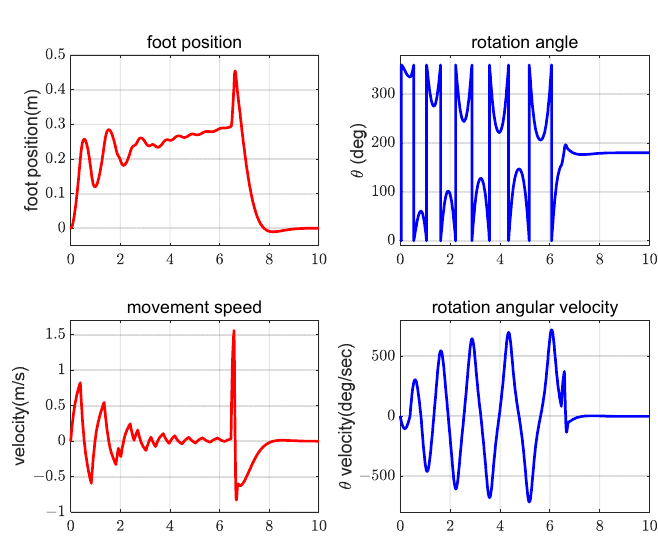
Figure 8. LQR control without interference.